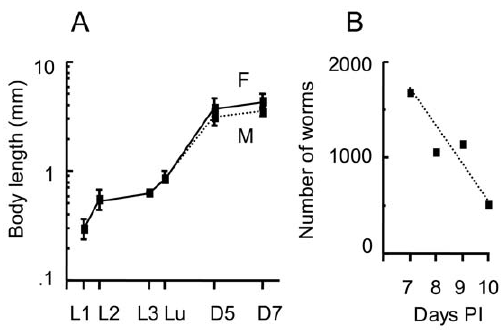
Figure 1. Development of N.brasiliensis . A . Development of N. brasiliensis . L1, 1st-stage larvae; L2, 2nd-stage larvae; L3, infective 3rd- stage larvae; Lu, lung stage-L3 larvae; D5, young adult worms collected at 5 days PI; D7, mature adult worms collected at 7 days PI. F, females; M, males. Data shown are mean and SD of 10–20 worms. B . Number of worms recovered from the intestine in the worm expulsion